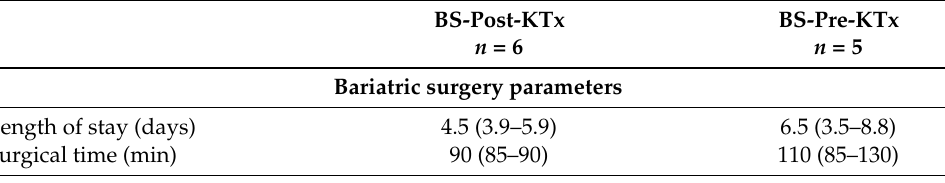
Table 2. Surgical procedure’s characteristics, complications and follow-up for BS-post-KTx and BS-pre-KTx